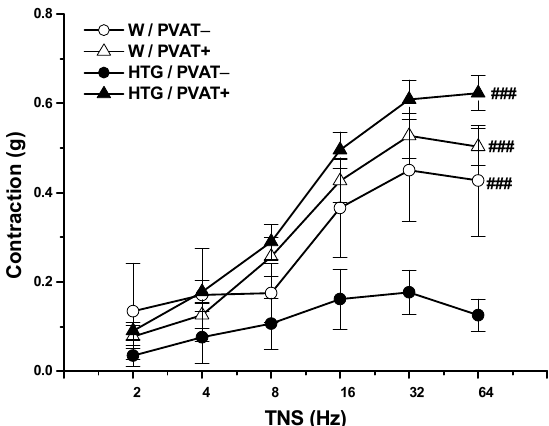
Figure 3. Contractile response of the mesenteric artery induced by endogenously released nora- drenaline after transmural nerve stimulation (TNS) in normotensive Wistar rats (W, n = 8) and hypertriglyceridemic rats (HTG, n = 9) with intact (PVAT+) or removed (PVAT − ) perivascular adipose tissue. The results are presented as the mean ± S.E.M, and differences between groups were analyzed by three-way ANOVA with the Bonferroni post hoc test on ranks. ### p < 0.001 vs. HTG/PVAT − .